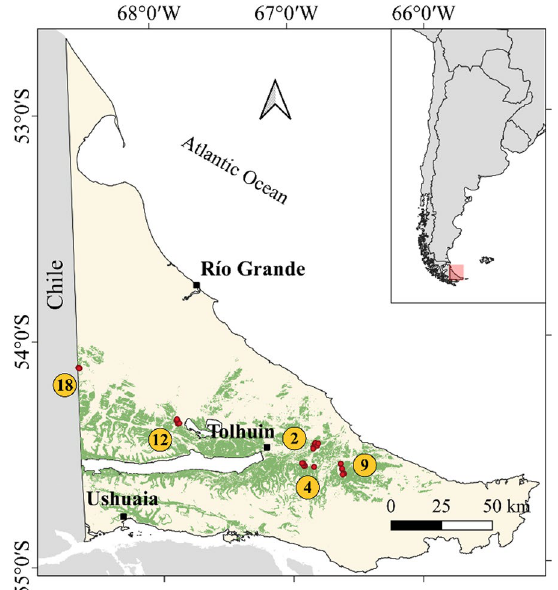
Fig. 1 Sampling forest landscapes and years after harvesting (2 to 18, orange circles), identifying the studied stands (red dots) in Tierra del Fuego, where Nothofagus pumilio forests are presented in green and cities in black